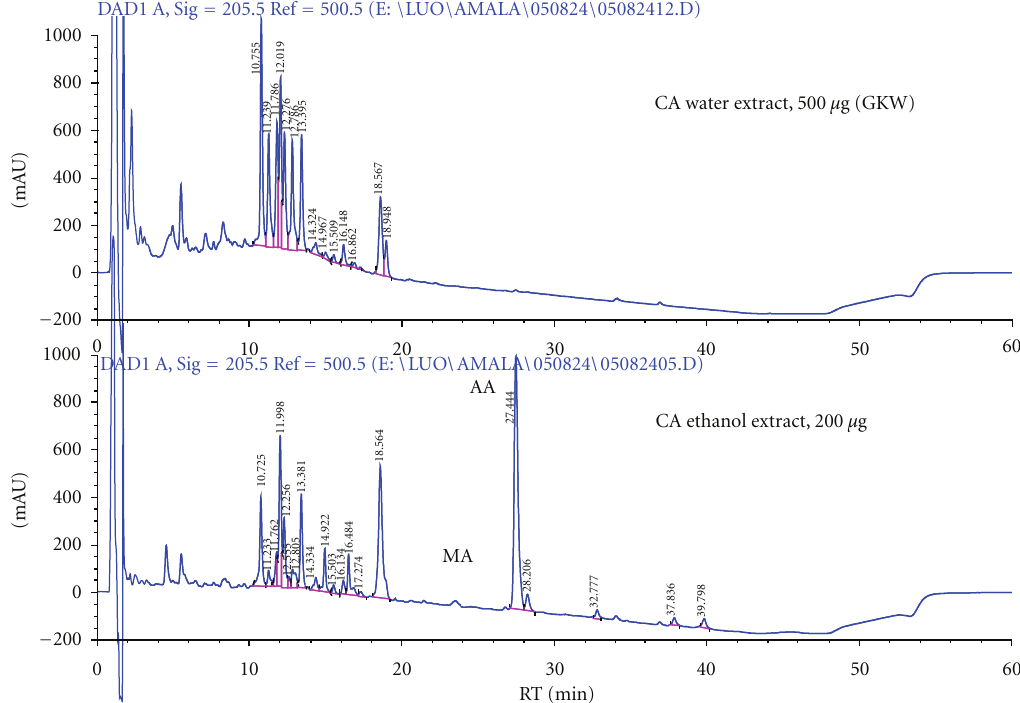
Figure 6: HPLC comparison of CA water and ethanol extracts made from the same batch of plant material. Asiatic acid (AA) and madecassic acid (MA) are detected in the ethanolic extract, but not in the water extract (GKW). The water extract GKW contains mostly very polar compounds as shown by their earlier elution than the triterpenes AA and MA. HPLC was conducted on an Aquasil 150mm × 2 . 1mm C18 column with acetonitrile:water gradient with 0.1% acetic acid. Acetonitrile concentration 10% at 0min, 50% at 25 min, 90% at 40 min, then returning to starting conditions, detector wavelength 205 nm. AA and MA were identified by comparison of retention times to those of com- mercial